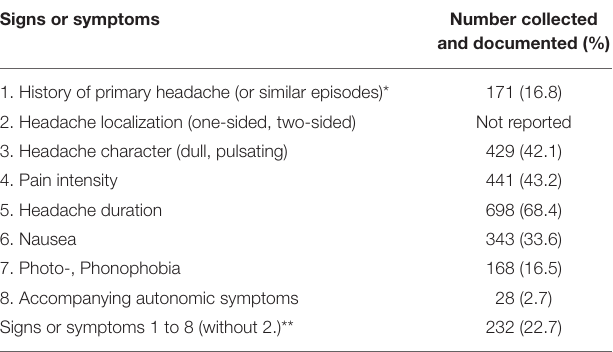
TABLE 2 | List of documented signs or symptoms for diagnosis according to ICHD-3 classification for emergency headache patients. Signs or